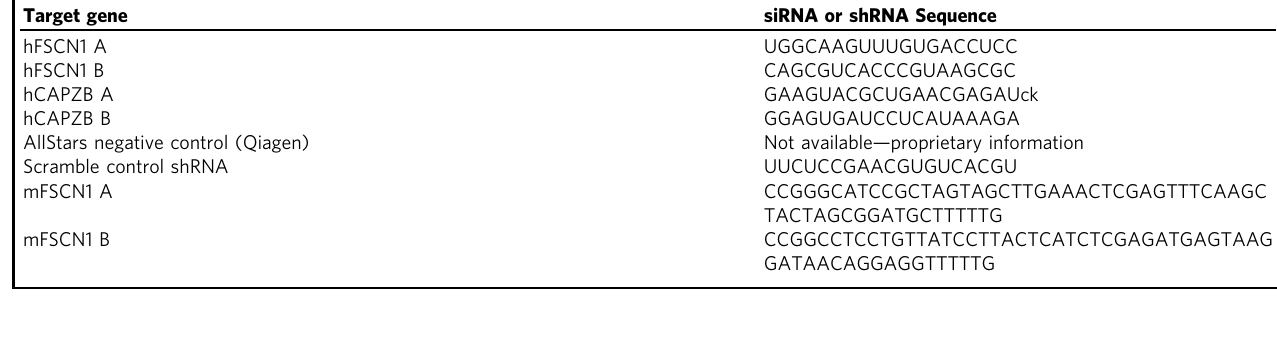
Table 1 siRNA and shRNA sequences. Target gene